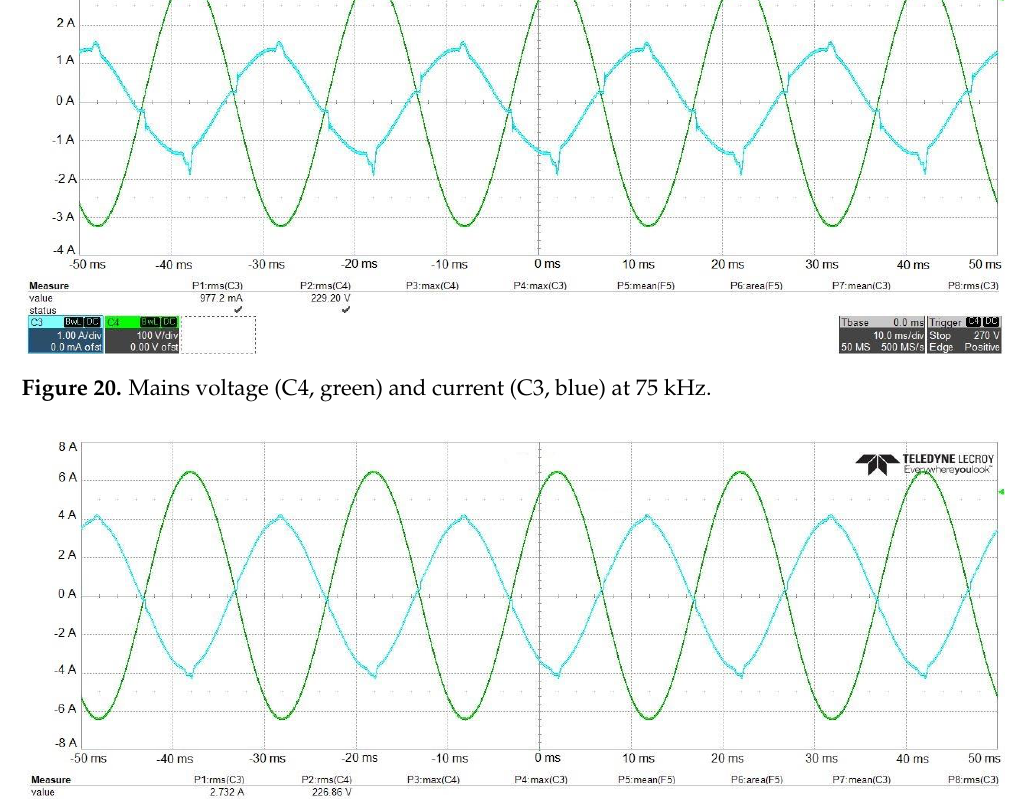
Figure 21. Mains voltage (C4, green) and current (C3, blue) at 39 kHz.